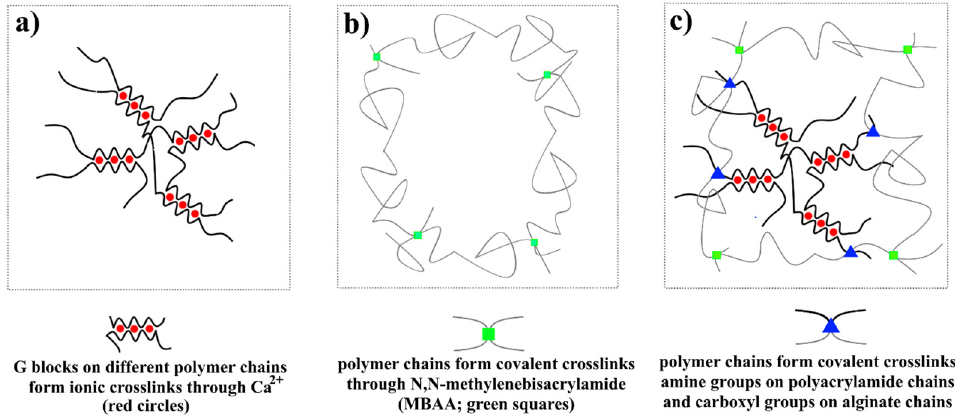
Figure 15. Schematics of three types of hydrogels based on alginate: ( a ) ionically crosslinked alginate chains, ( b ) covalently crosslinked polyacrylamide chains, ( c ) covalently crosslinked amine groups on polyacrylamide chains and carboxyl groups on alginate chains.